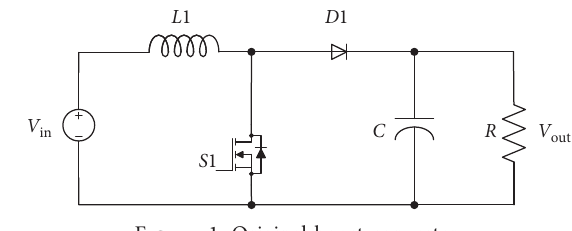
Figure 1: Original boost converter.